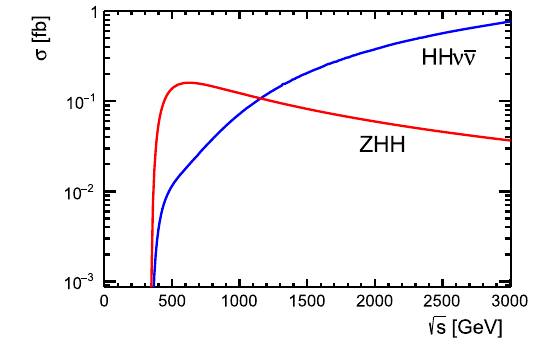
Fig. 1 Cross section as a function of centre-of-mass energy for e + e − → ZHH and e + e − → HH ν ¯ ν production for a Higgs boson mass of m H = 126 GeV. The values shown correspond to unpolarised beams including initial state radiation but not including the effect of beamstrahlung